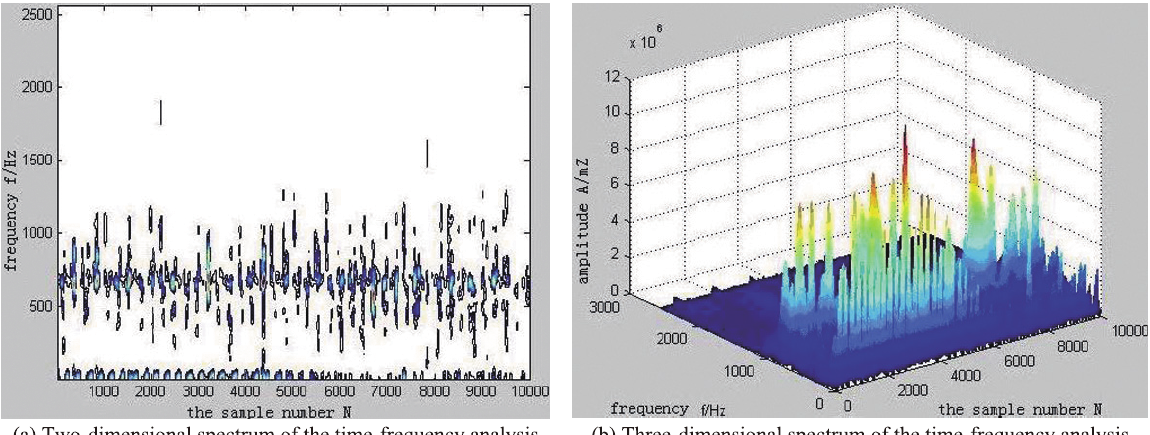
Fig. 11. The time frequency analysis of a pitch circle crack signal at 900 rpm.